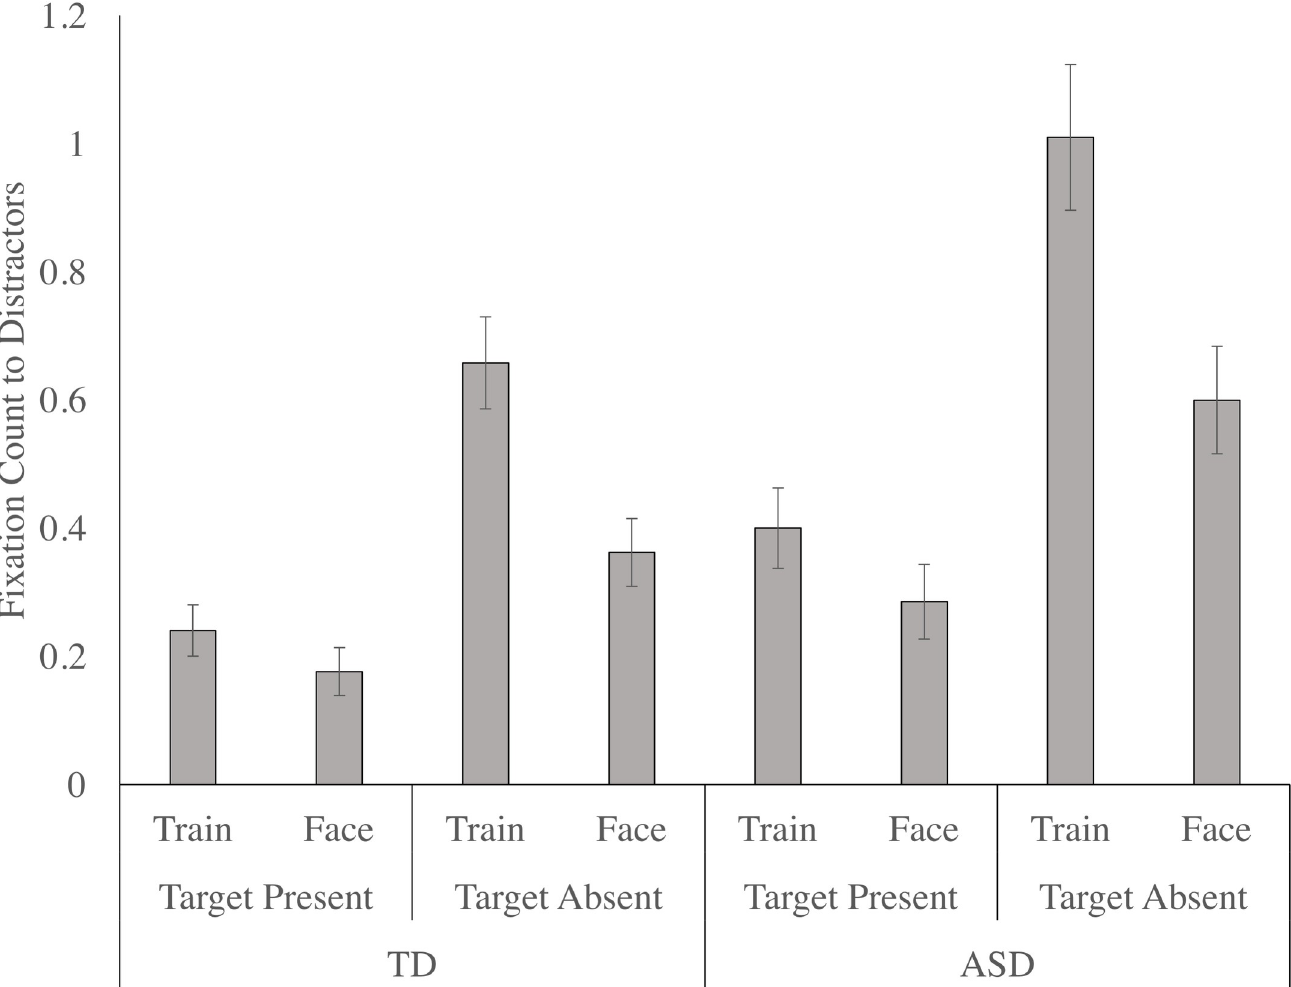
Fig 8. The number of fixations to the distractors (mean and standard error), for both the autistic and non-autistic children in the inverted condition as a function of target (present, absent) and distractor (train,